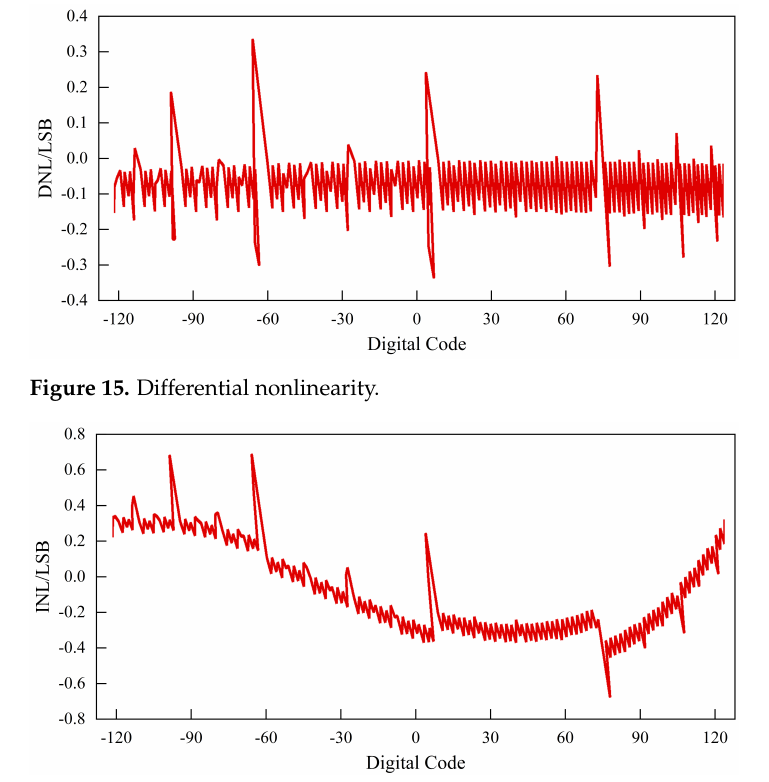
Figure 16. Integral